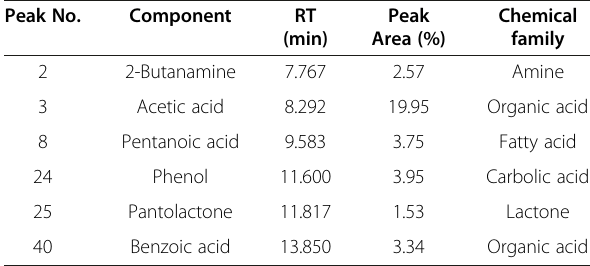
Table 1 Chemical constituents of AEBO, detected by GC-MS, with relative retention time ( t R) Peak No.